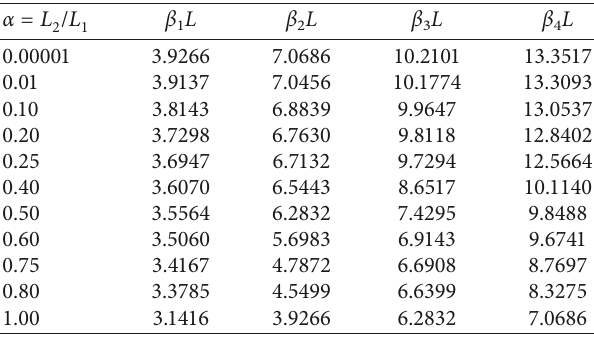
1 L 1 and α (cid:30)